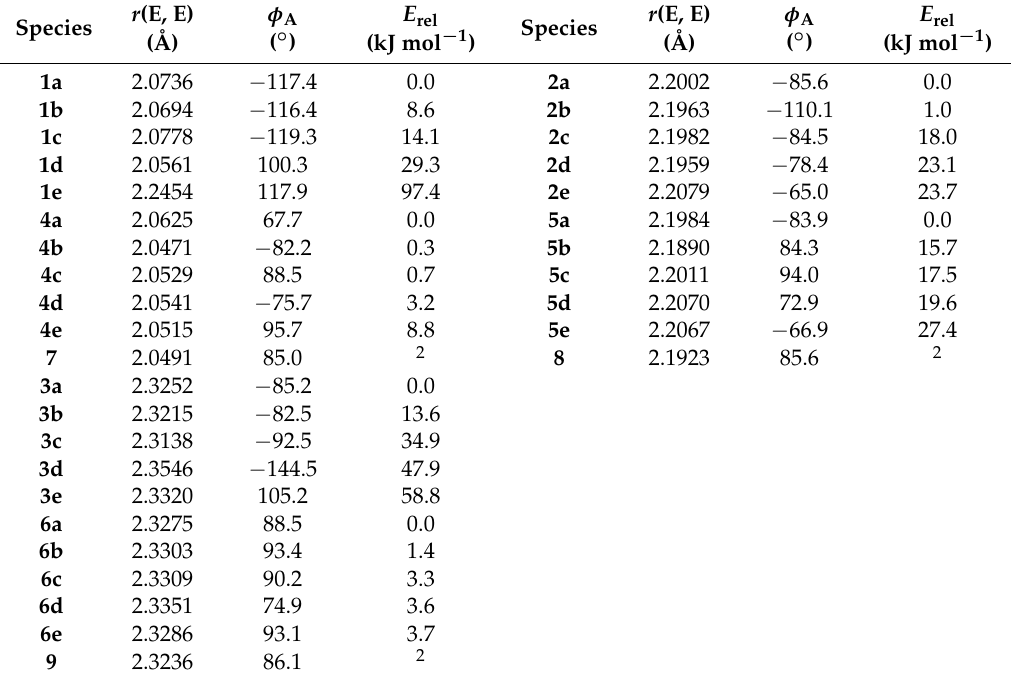
Table 1. Optimized r (E, E’) distances, torsional angles φ (CEE’C) (= φ A ) and E rel values for 1a – 6e and 7 – 9 , evaluated with M06-2X/BSS-A 1